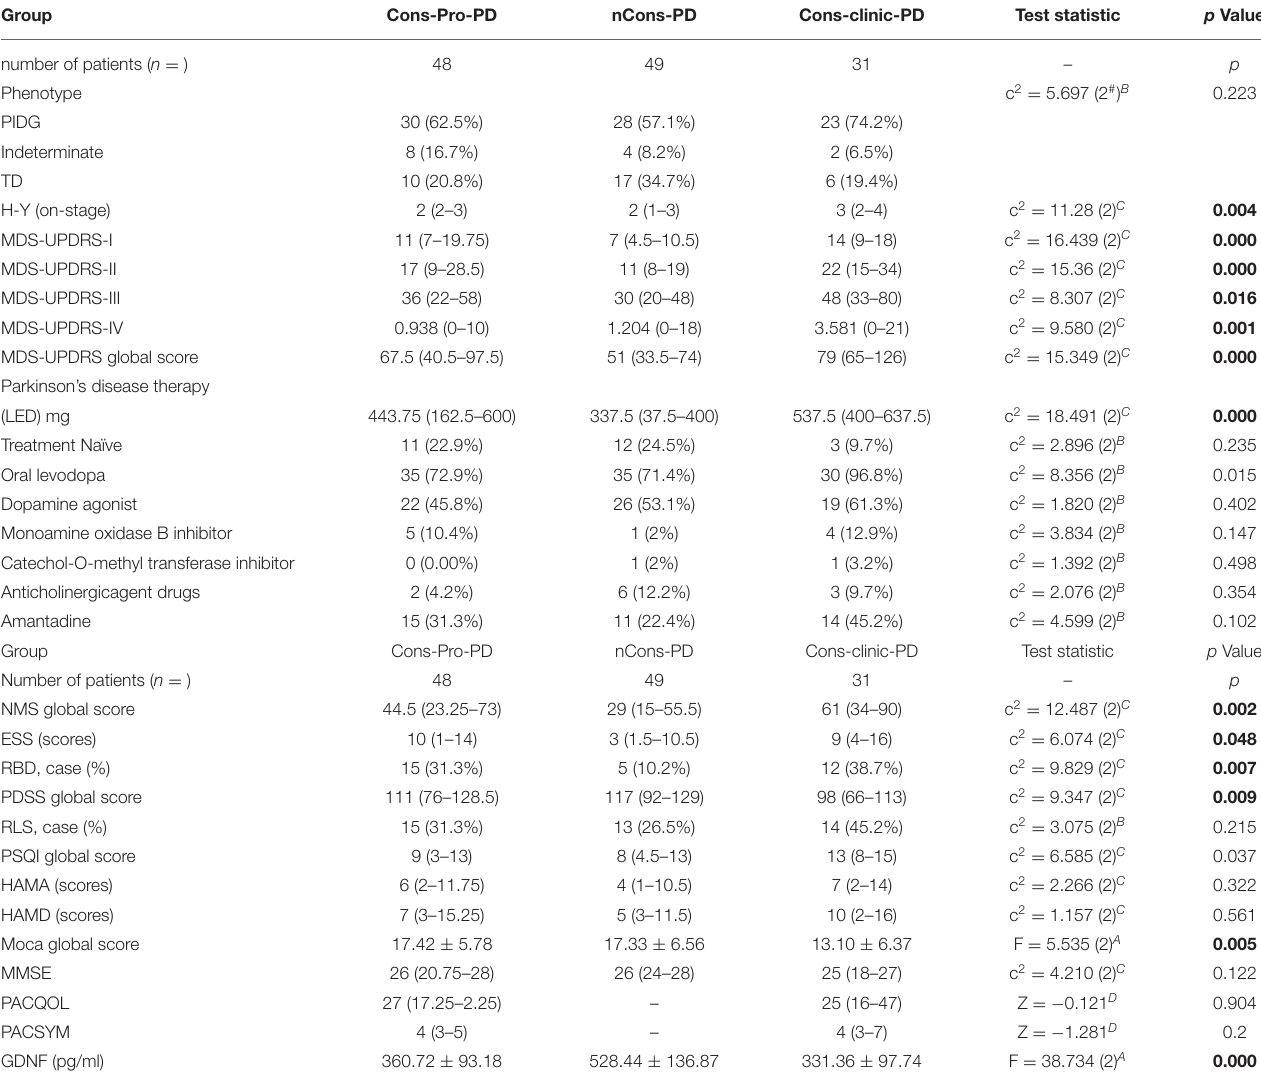
TABLE 2 | Clinical characteristics of the subjects in the study.